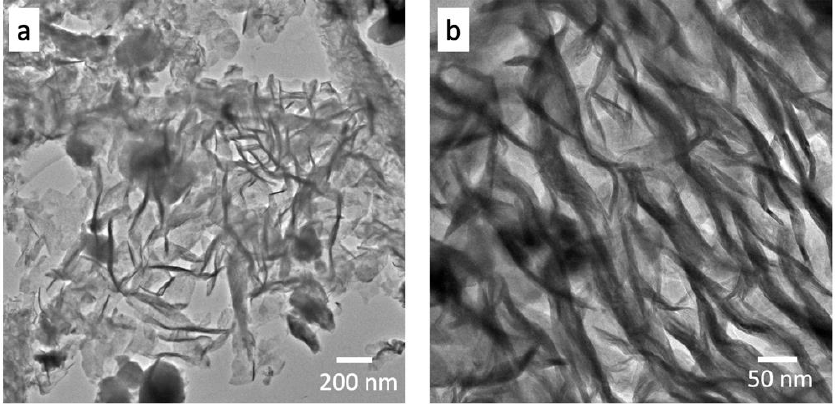
Figure 8. Bright-field TEM images of graphene@WS 2 nanocomposites: ( a ) low and ( b ) high magnification.